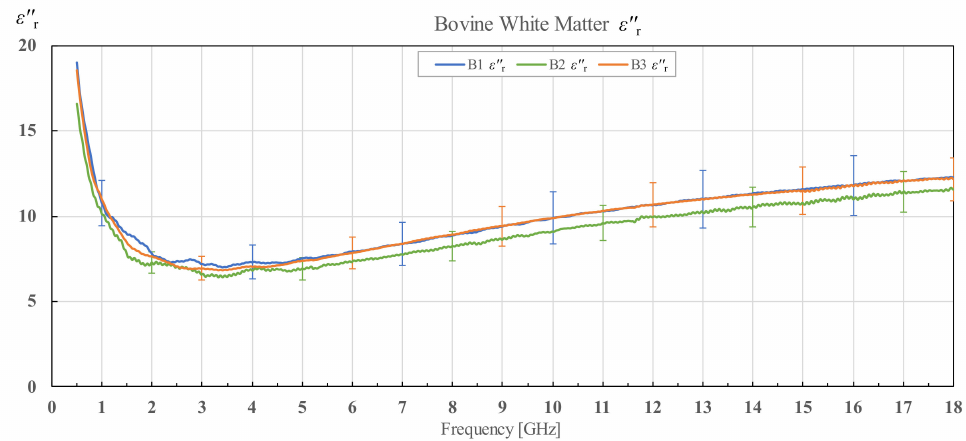
Figure 10. Imaginary part of permittivity of bovine white matter for brains B1, B2 and B3 with associated standard deviations.